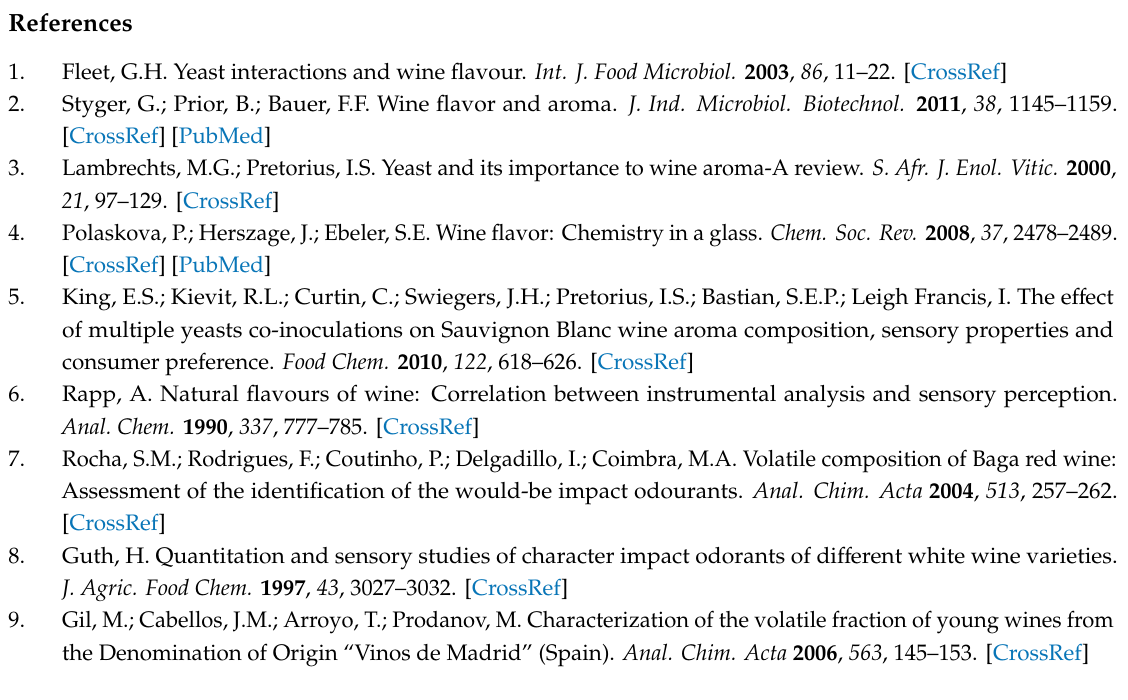
Table S1: Odor activity value (OAV) for the aroma compounds studied in Malvar wines, Table S2: Odor activity value proportion (% OAV) of each aromatic descriptor in wines elaborated with the Saccharomyces cerevisiae yeast